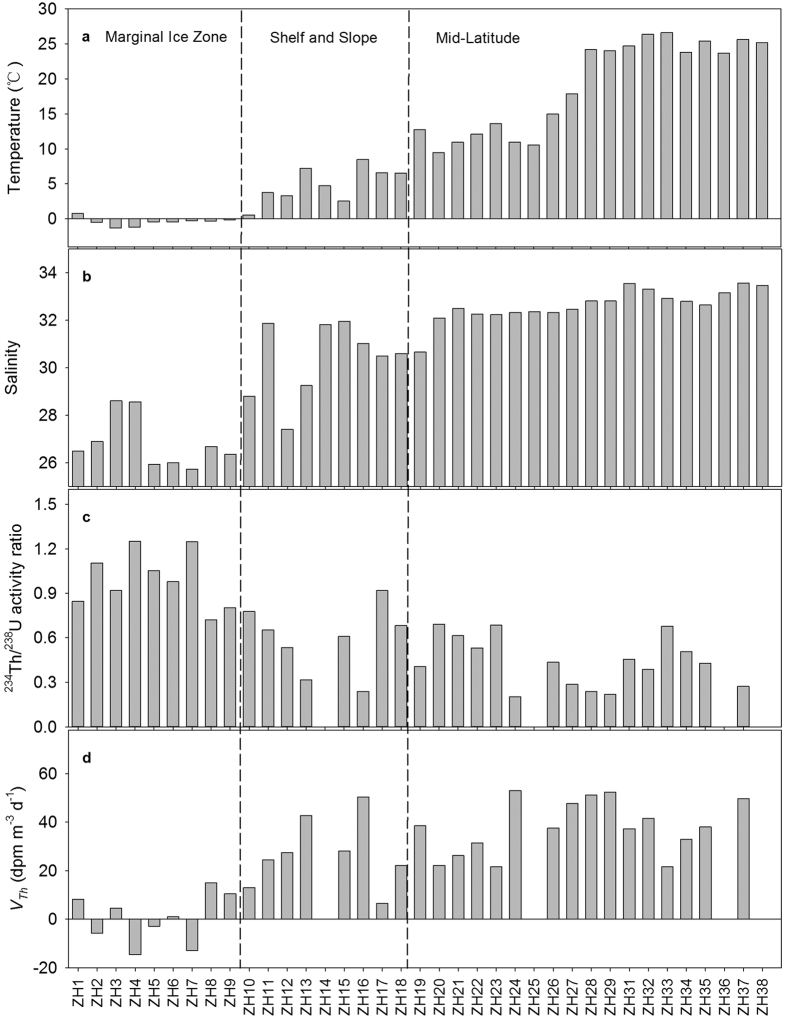
Latitudinal patterns of (a) temperature, (b) salinity, (c) disequilibria between 234Th and 238U, and (d) input/sinking rate of 234Th (VTh) to show the significantly different characteristics of the marginal ice zone.